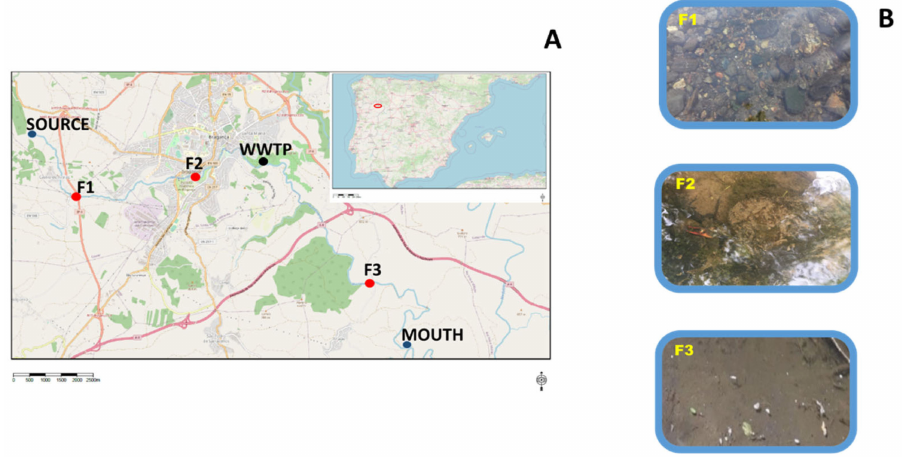
Figure 1. ( A ): Location of Fervença River, Bragança city, sampling sites and WWTP and ( B ): Riverbed conditions F1, F2, and